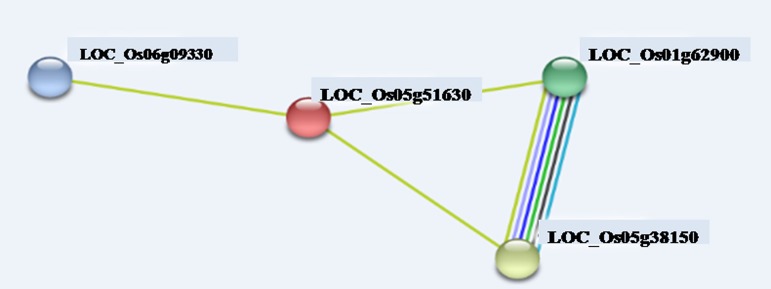
Protein interaction network of LOC_Os05g51630.In the network generated by STRINGV9.1, each node represents a protein and each edge represent an interaction, coloured by evidence type (see STRING website for colour legend). The original graphic output was modified to name the LOC number of the gene.